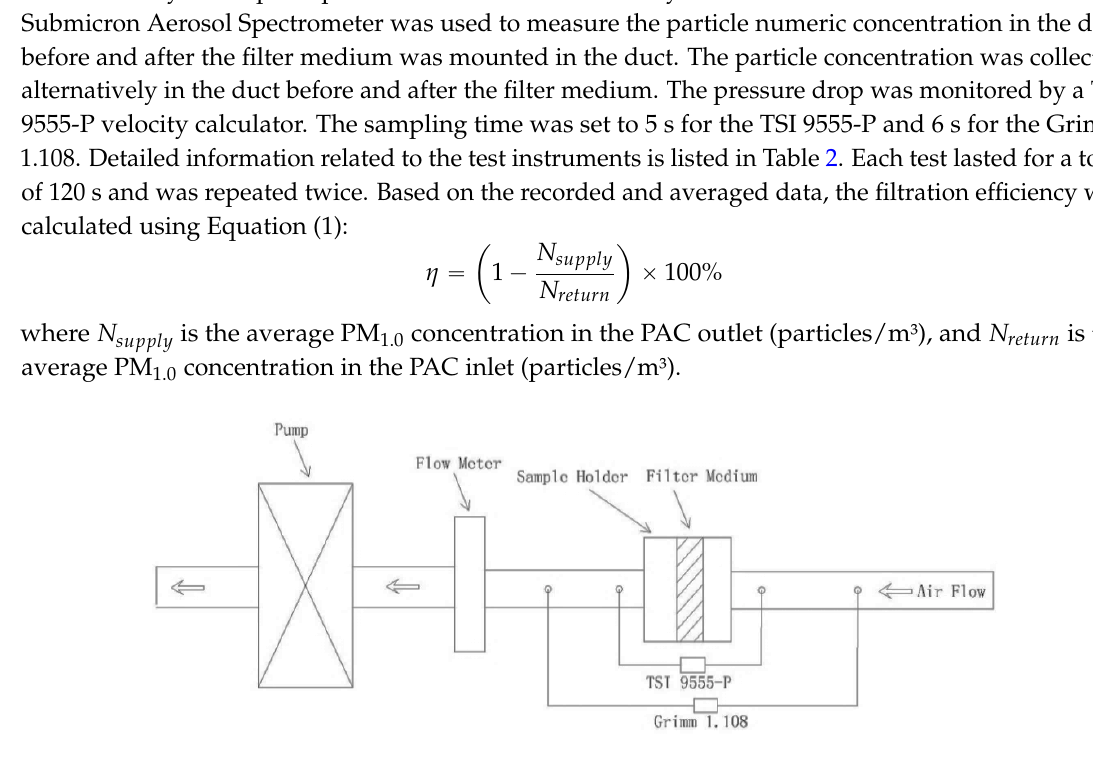
Figure 4. Schematic diagram of the duct system. Table 2. Test instruments for filtration characteristics.